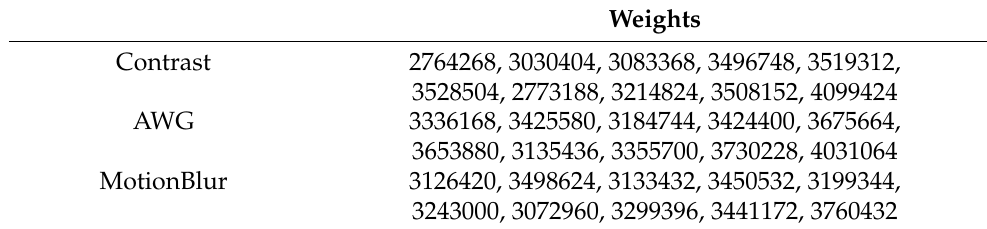
Table 1. Weights for the three noisy MNIST versions.